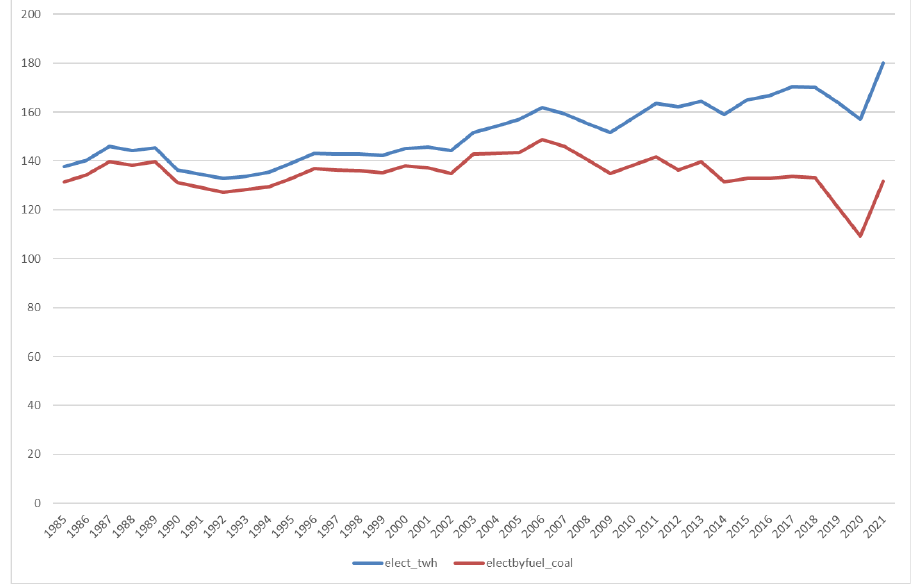
Figure 10. Electricity consumption in Poland overall and based on hard coal.